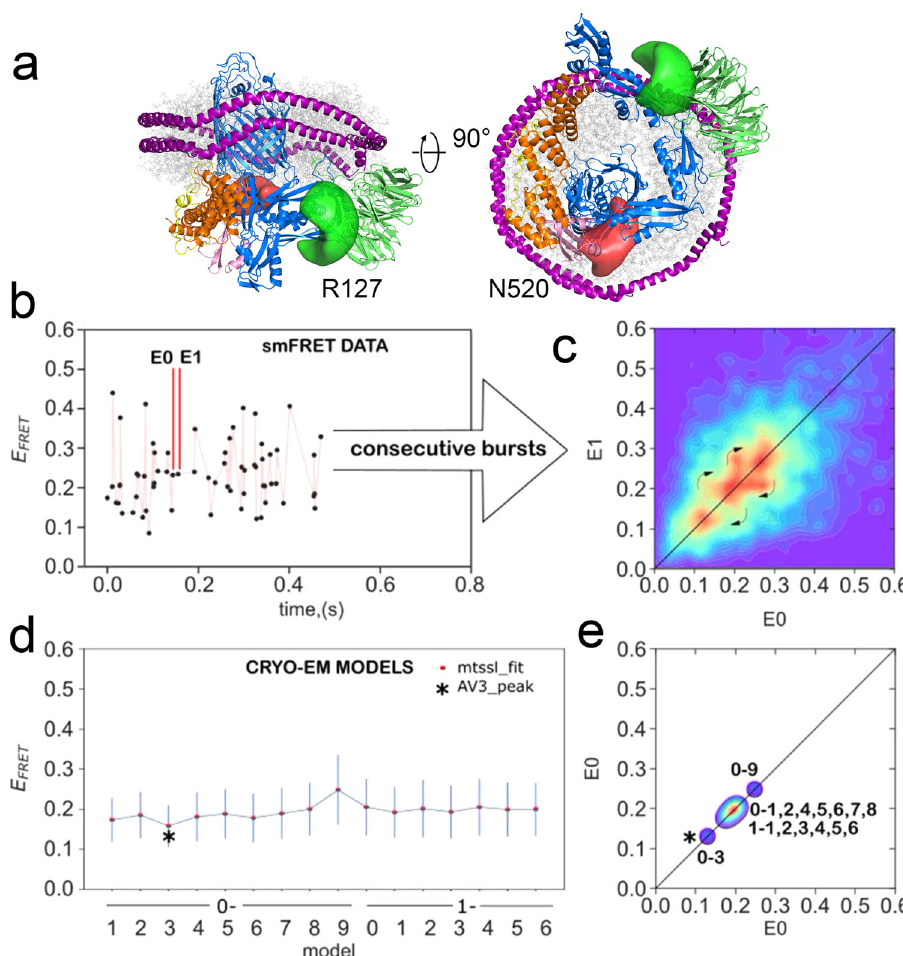
Fig. 6 Comparison of experimentally measured and predicted smFRET values of BAM in MSP1D1 nanodiscs. a Structure of a dye-labelled double- cysteine variant of BAM (R127C/N520C) predicted from the previous MD simulations. Green and red regions represent possible space fi lled by Alexa Fluor 488 and Dylight 594 maleimide, respectively. b Representative time trace showing E FRET values for single molecules. c Experimental 2D transfer- ef fi ciency contour plot (RASP analysis, see Methods) showing the measured E FRET between the dyes for pairs of consecutive bursts E0 and E1 with d t < 30 ms. Density on the diagonal line indicates persistent conformational states, while off-diagonal density indicates transitions between those states that occur on a 1 – 30-ms timescale (curved arrows). d Predicted E FRET for each of the 16 cryo-EM-derived model structures; each point represents the maximum of the predicted distribution as shown for selected structures in Supplementary Fig. 13a. e Projections of the predicted E FRET into a 2D plot for direct comparison with the experimental data (panel b ) showing that the static pattern of density along the diagonal could be recapitulated by the 16 cryo-EM-derived model structures. An alternative modelling approach afforded a better match for the data in the case of one structure (0 – 3 black